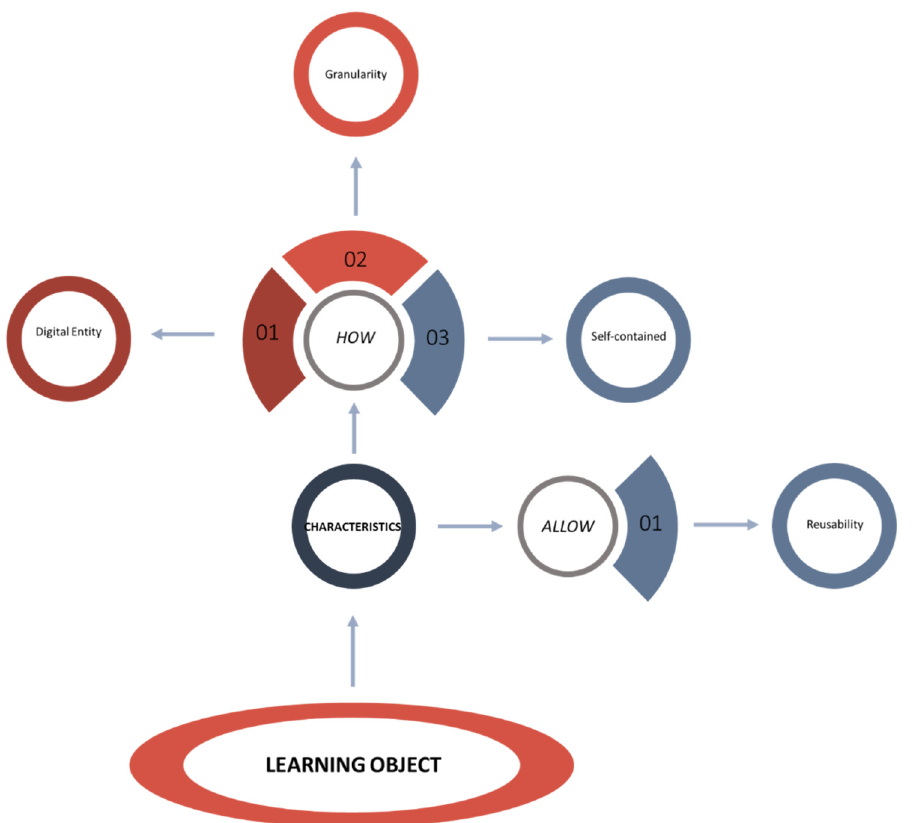
Figure 2. Taxonomy of learning objects. Features . Source: Based on Cuervo (2011); Castrillón (2011); Sánchez Medina (2014).